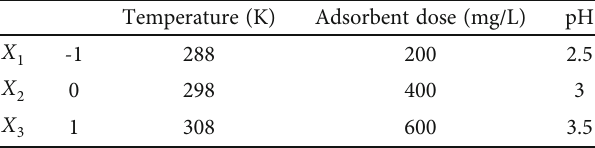
Table 1: Factors and values of Box-Behnken design.